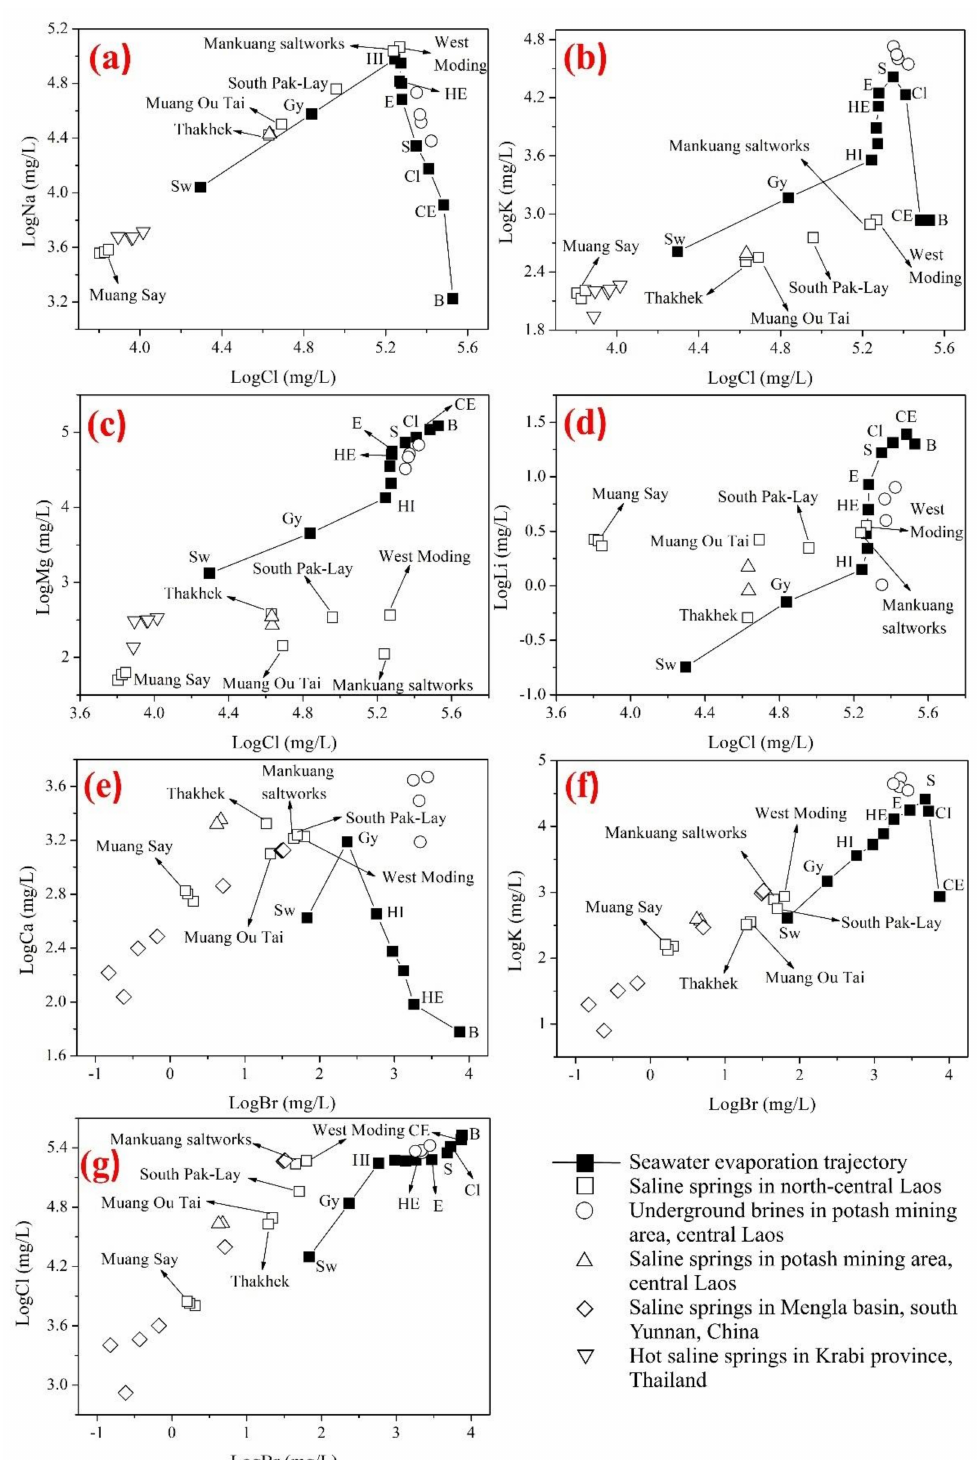
Figure 5. Plot of Cl vs. Na ( a ), Cl vs. K ( b ), Cl vs. Mg ( c ), Cl vs. Li ( d ), Br vs. Ca ( e ), Br vs. K ( f ), and Br vs. Cl ( g ); SET, HDL, Sw, Gy, HI, HE, E, S, CI, CE, and B represent seawater evaporation trajectory [80], halite dissolution line [84], seawater, gypsum precipitation point, halite precipitation initial point, halite precipitation end point, epsomite precipitation point, sylvite precipitation point, carnallite precipitation initial point, carnallite precipitation end point, and bischofite precipitation point [80], respectively. Date of underground brines and saline springs in potash mining area, central Laos from [66], saline springs in Yunan from [85], and hot saline springs in Thailand from